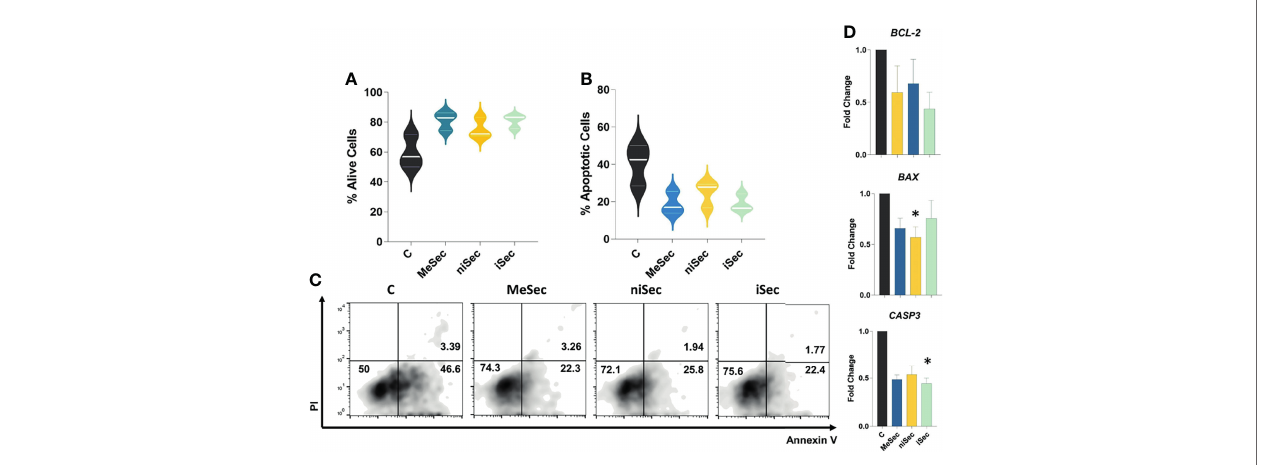
FIGURE 3 | MeWo conditioned media do not stimulate T cell apoptosis. (A, B) Percentage of alive (annexin V-/PI-) and apoptotic (annexin V+) T-cells after culture of PHA-activated PBMCs in RPMI (C) , MeSec, niSec, and iSec. (C) Representative fl ow cytometric density plots showing expressions of PI and Annexin V in T-cells. (D) BCL-2, BAX and CASP3 transcriptional levels in PHA-activated PBMCs cultured in RPMI (C) , MeSec, niSec, and iSec. Experiments were carried out with 3 PBMCs donors. Results are presented as mean ± SEM. *p < 0.05. For the fl ow cytometry analyses, ten thousand events were recorded for each